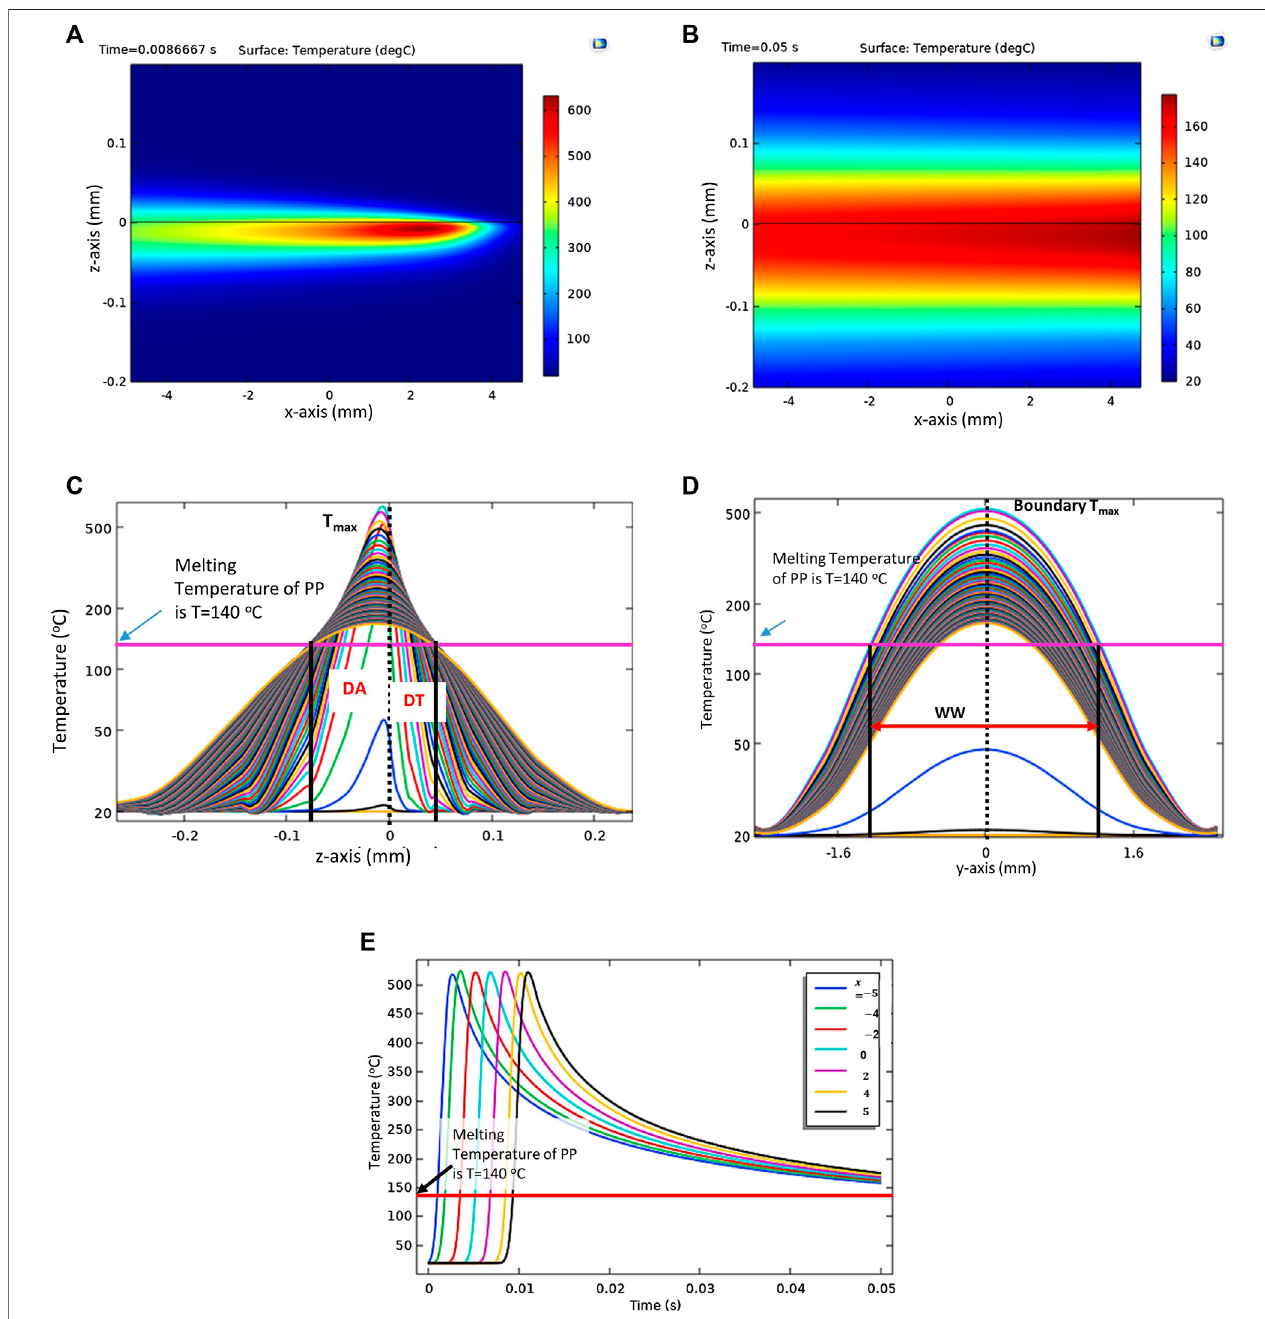
FIGURE6| Thermalpro fi le(temperature)at (x,0,z)planeduringLTWat (A) t (cid:1) 0.0087 sand (B) t (cid:1) 0.05 ssimulatedfortheabsorptivelayerof1.0 wt%CB/PP for p (cid:1) 120 W,speed (cid:1) 1,200 mm/swithbeamdiameter1.9mm, (C) temperaturecurvesevolutionwithtimeduringLTWalong z -axisatx (cid:1) y (cid:1) 0usedforthemeasurement of weld depth for transmissive layer (D T ) and absorptive layer (D A ), (D) temperature curves evolution with time during LTW along y -axis at x (cid:1) z (cid:1) 0 used for the measurement of weld width (WW) and (E) temperature versus time at x (cid:1) − 5, − 4, − 2, 0, 2, 4, and 5.